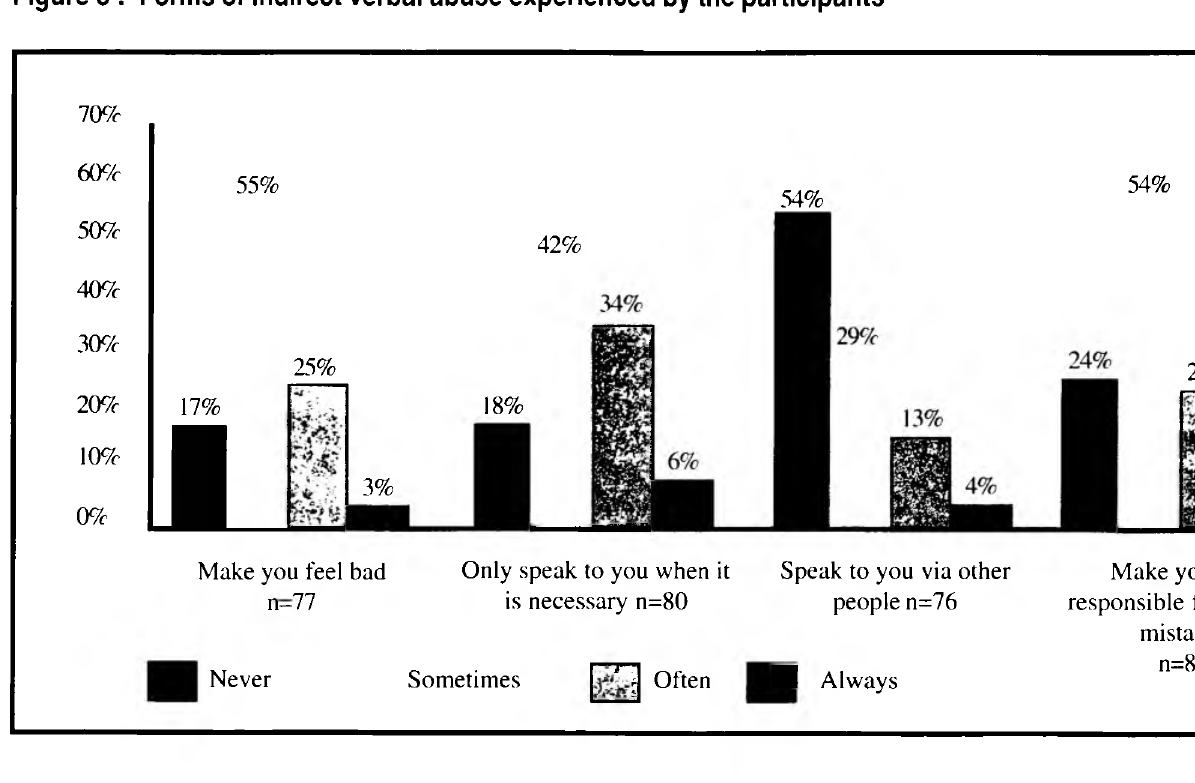
Figure 5 : Forms of indirect verbal abuse experienced by the